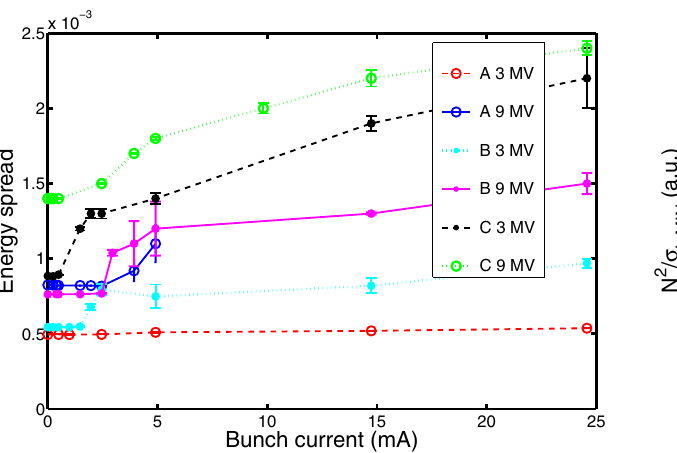
FIG. 16. (Color) Ratio of the second power of the stored current over the minimum bunch